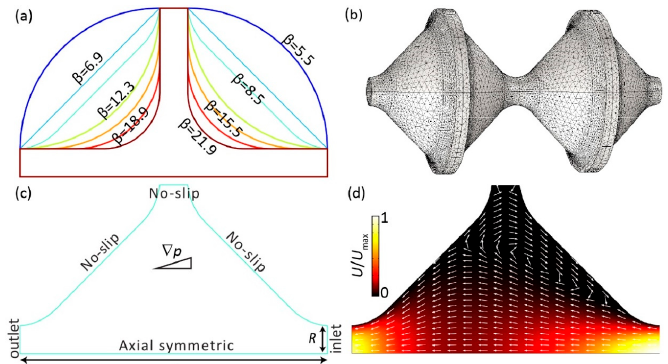
5.5 to 21.9). ( b ) A 3D rendition of pore geometry consisting of two periodic pores for the case with β = 8.5. ( c ) A 2D pore geometry with β = 8.5 showing the boundary conditions, where L is length of domain, R is the radius of pore throat, ∇ p is pressure gradient. ( d ) A representative normalized velocity field encoded by color for pore geometry with β = 8.5, where U is the magnitude of velocity with its maximum U max , the white arrow indicates flow